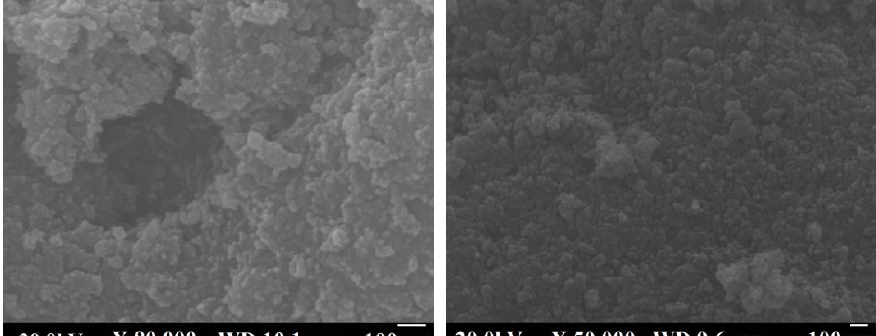
Figure 10. SEM images of the obtained magnetite particles synthesized at 25 °C with a flow rate of 150 mL/min ( left ) and at 75 °C with a flow rate of 250 mL/min ( right